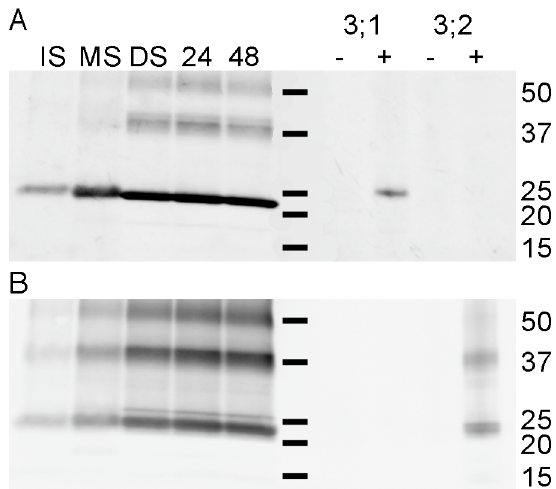
Figure 4. Immunodetection of PvTIP3;1 and PvTIP3;2 in seed membranes. Western immunoblots colabeled with ( A ) aTIPnt13C and ( B ) bTIPnt15C antisera. Blot lanes: IS, immature seed; MS, mature seed; DS, dry seed; 24, seed imbibed for 24 h; 48, seed imbibed for 48 h. Proteins of 40 and 57 kDa were also labeled and are likely oligomers as observed previously with PvTIP3;1 [5,15,34]. To monitor antisera specificity, labeling controls for PvTIP3;1 ( 3;1 ) and PvTIP3;2 ( 3;2 ) shown on right, with aliquots from washed microsomes of PICZ-vector only transformed Pichia pastoris ( - ) or yeast expressing the indicated protein ( + ). Position of molecular weight markers (central bars) with kDa values at the right.